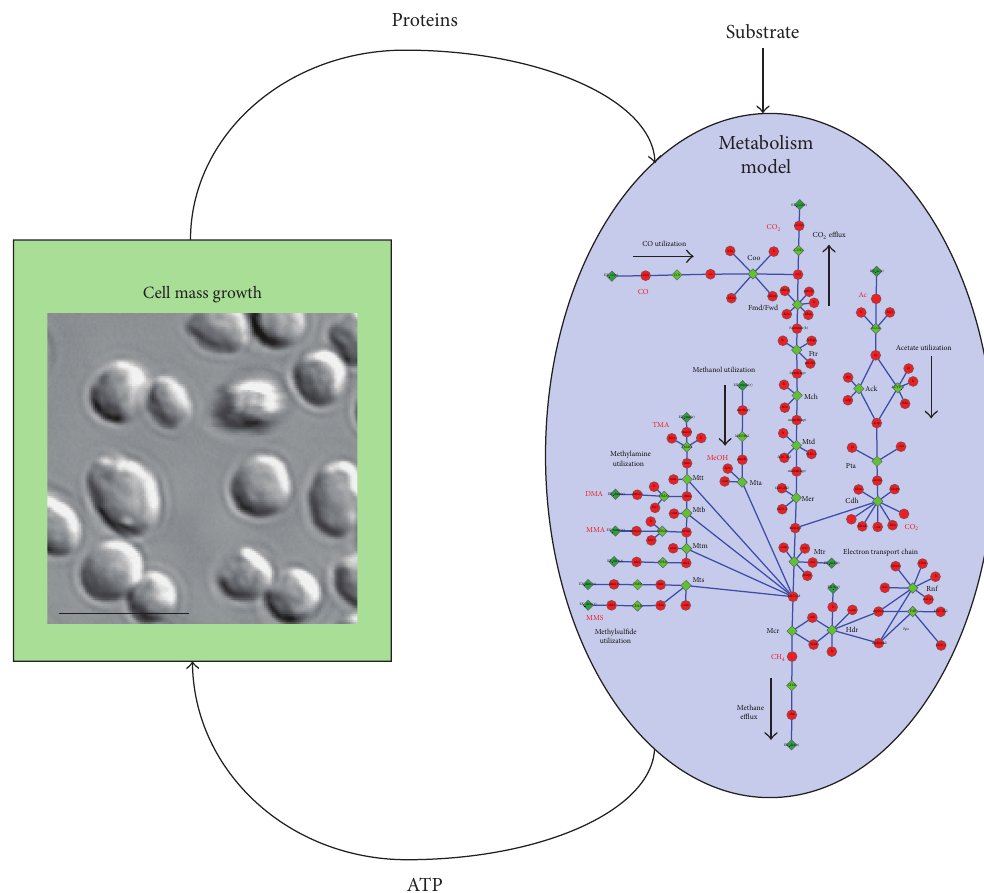
Figure 5: A schematic of the kinetic model. Flux of ATP from the methanogenesis pathway (see Figure 4) feeds into a cell growth term that updates protein numbers used by the kinetic model, simulating the growth when fed on a certain substrate. The inset in the cell mass growth expression is from DIC microscopy with a 5 𝜇 m scale